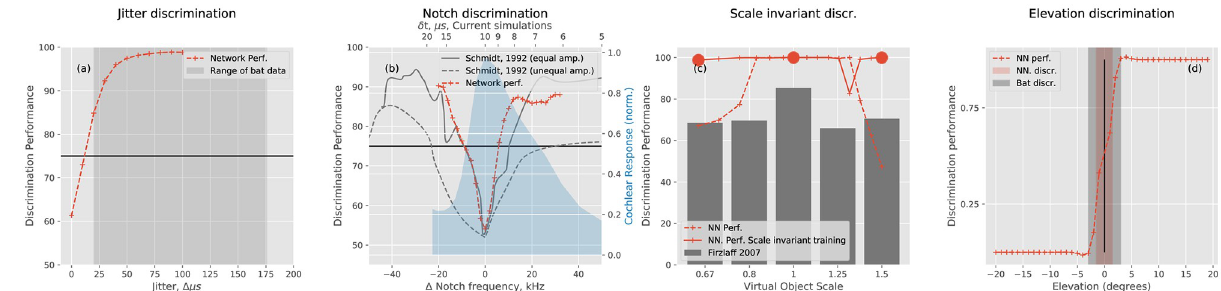
Fig 4. All red curves depict neural network performances. Grey data shows behavioral data taken from previously published experiments. (a) The results from modeling a delay discrimination task, e.g., as described by Denzinger and Schnitzler [31]. In gray, we depict the range of discrimination thresholds found in the literature ([30] and references therein). (b) Results from mimicking the frequency notch (or internal delay) discrimination experiments by Schmidt [32]. This panel shows the behavioral results of two experimental conditions tested. In one condition, the leading and the trailing echo had equal amplitudes. The amplitudes differed by 6 dB in a second condition, making discrimination harder for the bats (see text). (c) Firzlaff et al. [34] trained bats to discriminate two phantom objects (scale 1). Next, the bats were able to generalize and discriminate between scaled versions of these objects. The neural network was able to make the same generalization but for scale = 1.5. A second network trained on a subset of scaled phantom objects (red dots) could better interpolate to intermediate scales. (d) Results from training a network to discriminate between phantom echoes coming from above and below the horizon. This results in an estimate of the vertical angle acuity that is better but comparable to the value measured in the behavioral experiments conducted by Lawrence, Simmons and Wotton [5, 35].